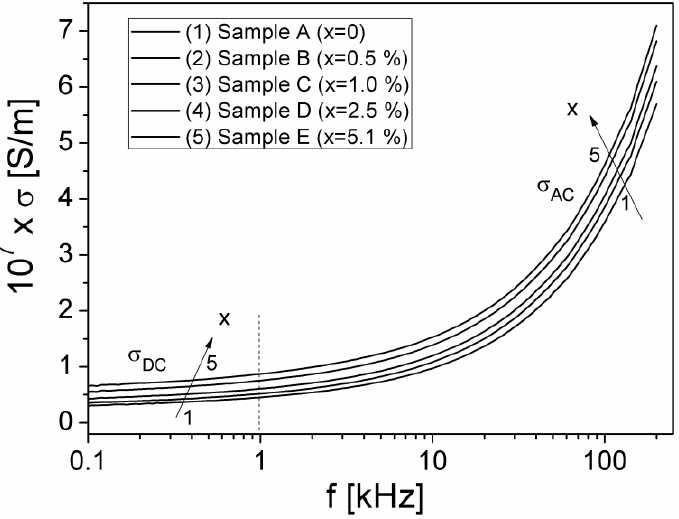
Figure 8. The frequency dependence of the conductivity σ , at different volume fractions, x of the Al particles dispersed in the composite material.